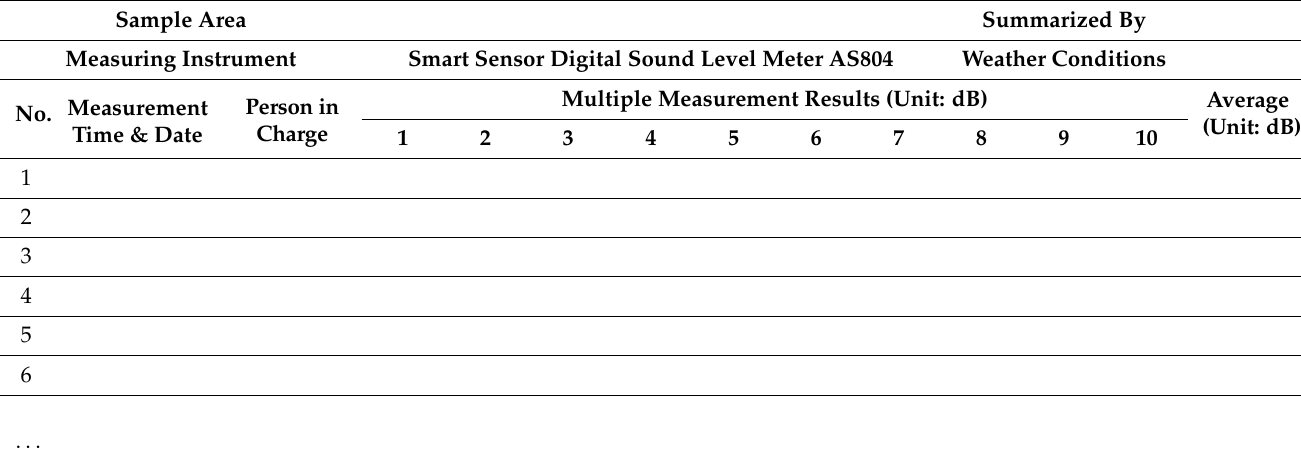
Table A4. Summary of the sound level